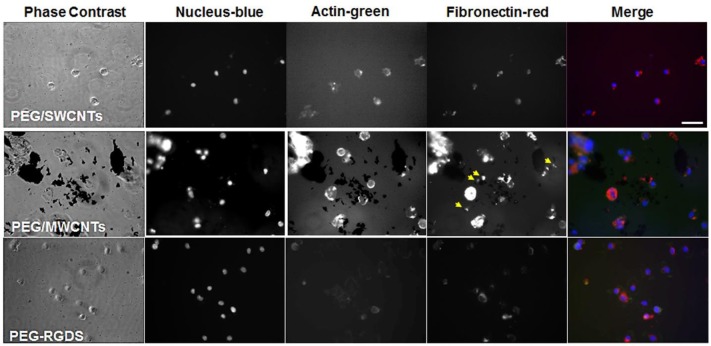
Fluorescence images of NIH 3T3 cells on PEG/SWCNTs, PEG/MWCNTs and PEG-RGDS hydrogels at 2 h in serum-free medium. Nucleus was stained with Hoechst 33258 (blue), actin was stained with Alexa 488 phalloidin (green) and fibronectin was stained with polyclonal anti-fibronectin (red). Scale bar is 50 μm. Arrows indicate extracellular fibronectin.